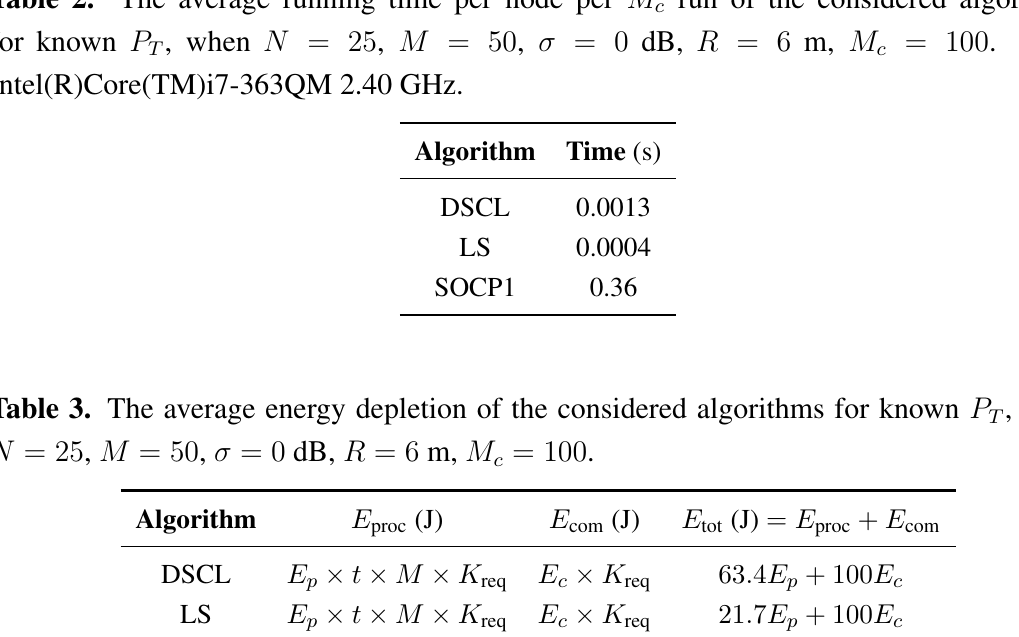
run of the considered algorithms c = 100 . CPU: c